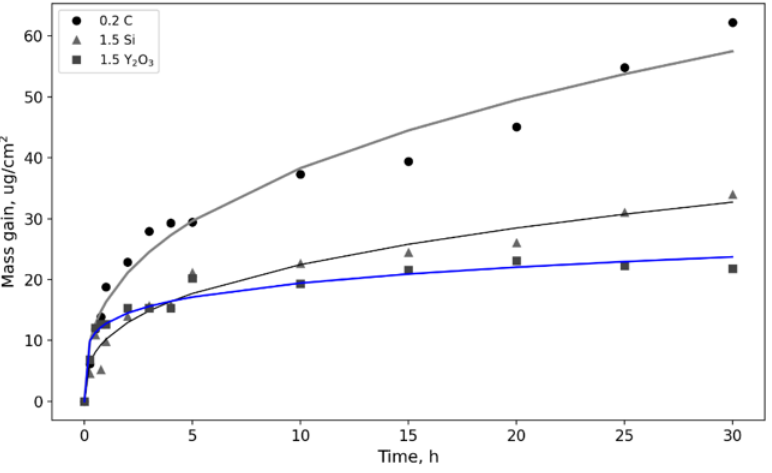
Figure 7. The sample images after annealing at 1100 °C.